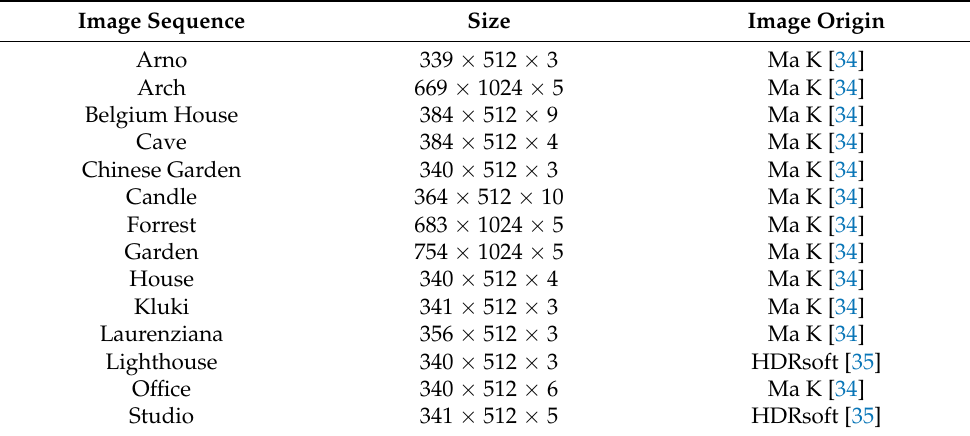
Table 1. Information on image sequences relevant to this article.